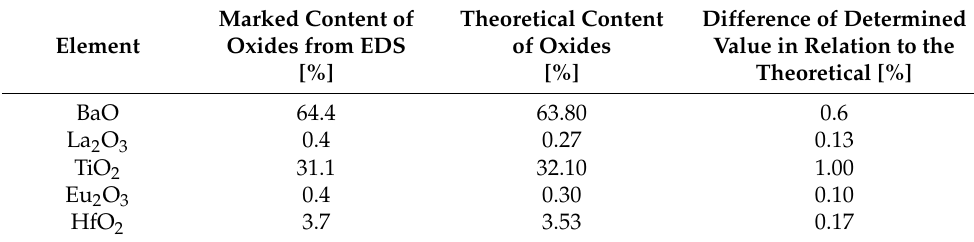
Table 4. Theoretical and experimental percentages of BLT4 + Eu + Hf ceramic elements.